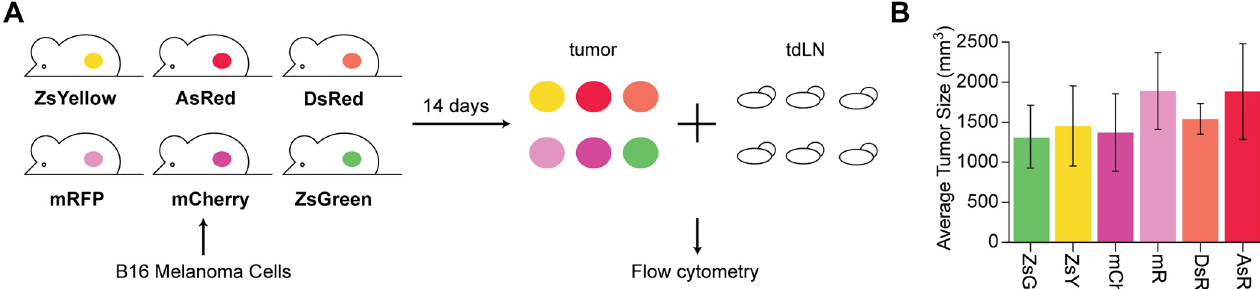
Fig 3. Growth and harvest of respective fluorescent cell lines. A) Fluorescent cell lines were grown, harvested, and injected subcutaneously on the flanks of B6 mice. After 14 days, tumors and draining lymph nodes were harvested and processed for flow cytometry. B) Average sizes of tumors (mm 3 ) at harvest are shown for all six respective fluorophores. Size was controlled to ensure comparable in vivo growth of different FP-expressing B16-F10 cell lines.